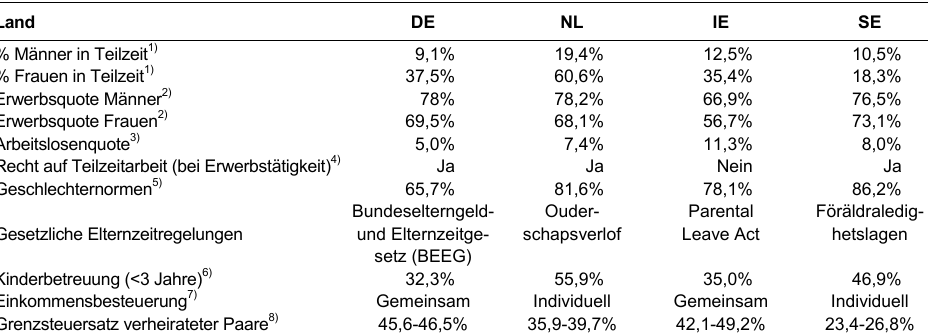
Tabelle 1 : Ländercharakteristika im Überblick,